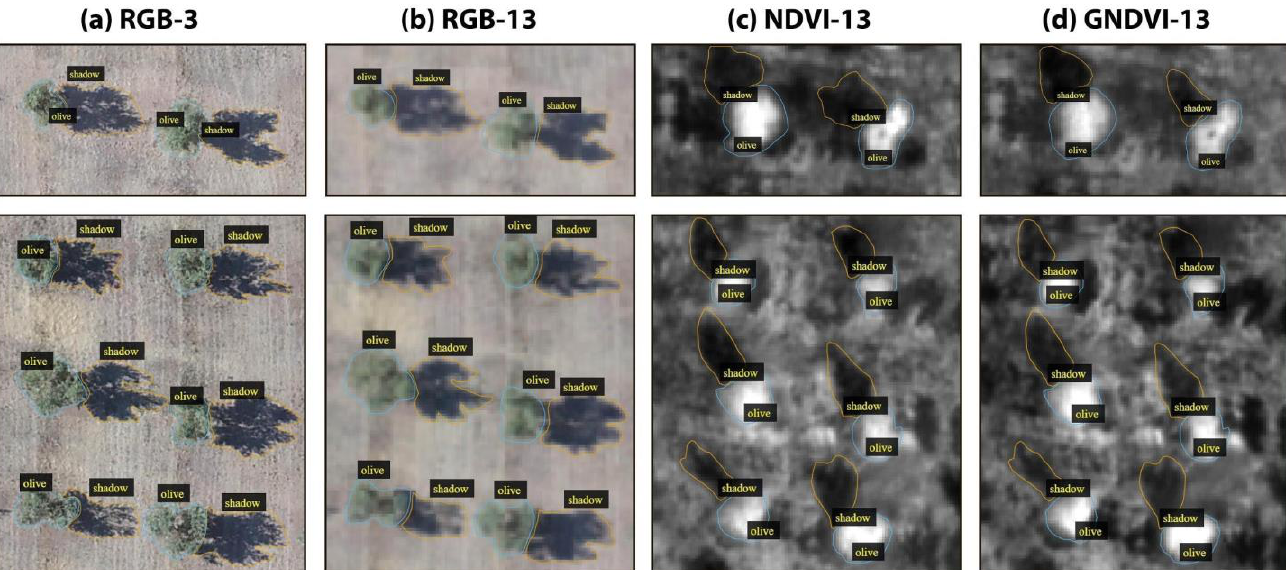
Figure 3. Examples of two image patches (first and second rows) in the four subsets of images (four columns) used to assess the effect of decreasing spatial resolution (RGB-3 versus RGB-13) and gaining spectral information (RGB-13 versus NDVI-13 OR GNDVI-13) for the task of instance segmentation of olive tree crowns and shadows in the OTCSS-dataset. ( a ) RGB-3 cm/pixel, ( b ) RGB-13 cm/pixel, ( c ) NDVI-13 cm/pixel and ( d ) GNDVI-13 cm/pixel. RGB: Red, Green, Blue; NDVI: normalized difference vegetation index; GNDVI: green normalized difference vegetation index. Table 2. A brief description of the number of image patches and segments in the four subsets of the Olive Tree Shadow Segmentation in the OTCSS-dataset: RGB-3 cm/pixel, RGB-13